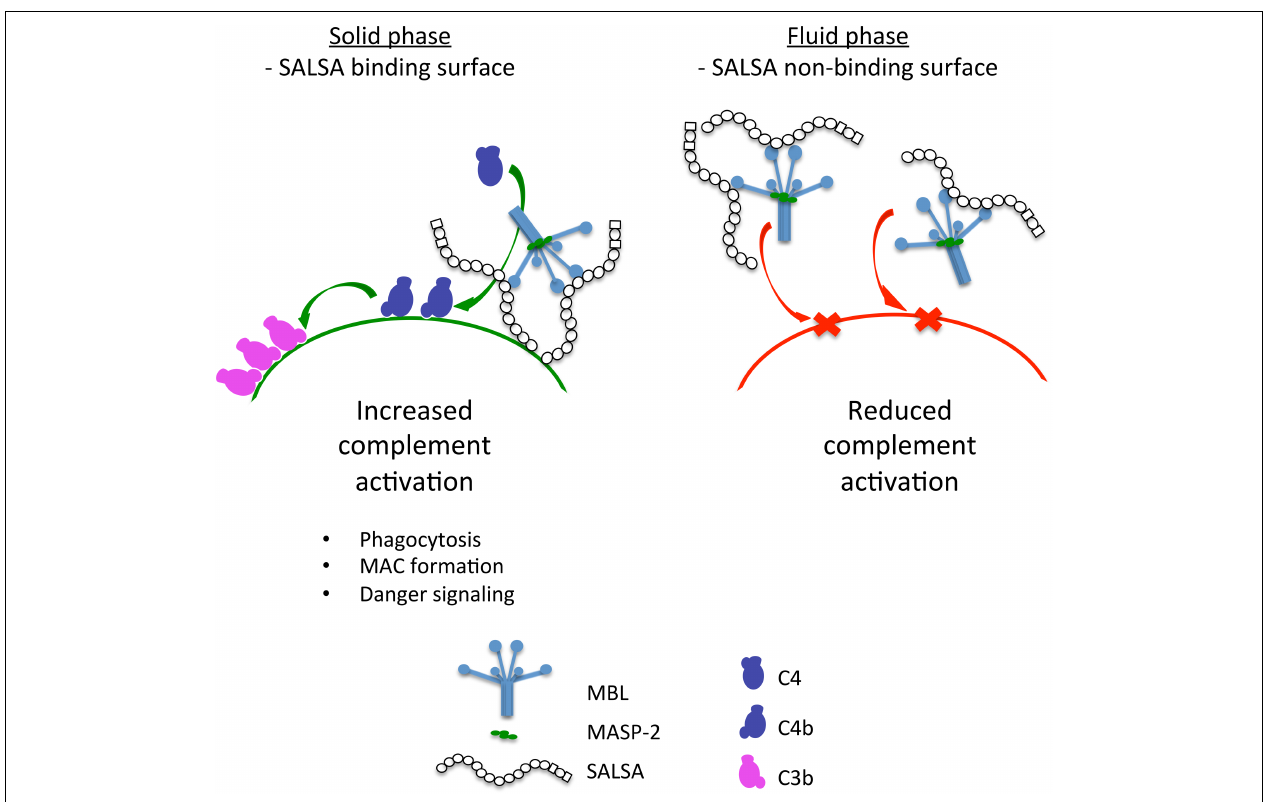
FIGURE 8 |A graphical presentation of the dual function of SALSA. Binding of SALSA to a surface allows recruitment of MBL, C1q, and ficolins and subsequent complement activation. In contrast, soluble SALSA interacts with MBL in the fluid phase drawing it away from the surface. Consequently, the lectin pathway of complement is